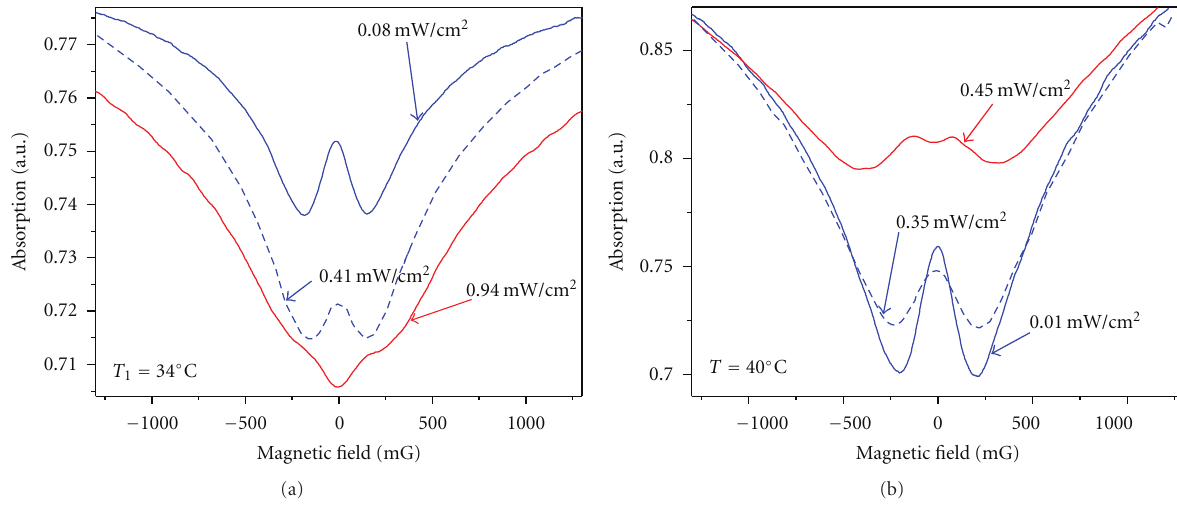
Figure 10: Sign reversal of the CPT resonance with the light intensity observed for the F g = 4 → F e = 5 transition in L = 700 μ m cell. Two di ff erent temperatures of the atomic source are used: 34 ◦ C (a) and 40 ◦ C (b). At 40 ◦ C, the sign-reversal process is observed for lower light intensity (0.45mW/cm 2 ) as compared to T = 34 ◦ C, where the e ff ect is observed at 0.94mW/cm 2 .